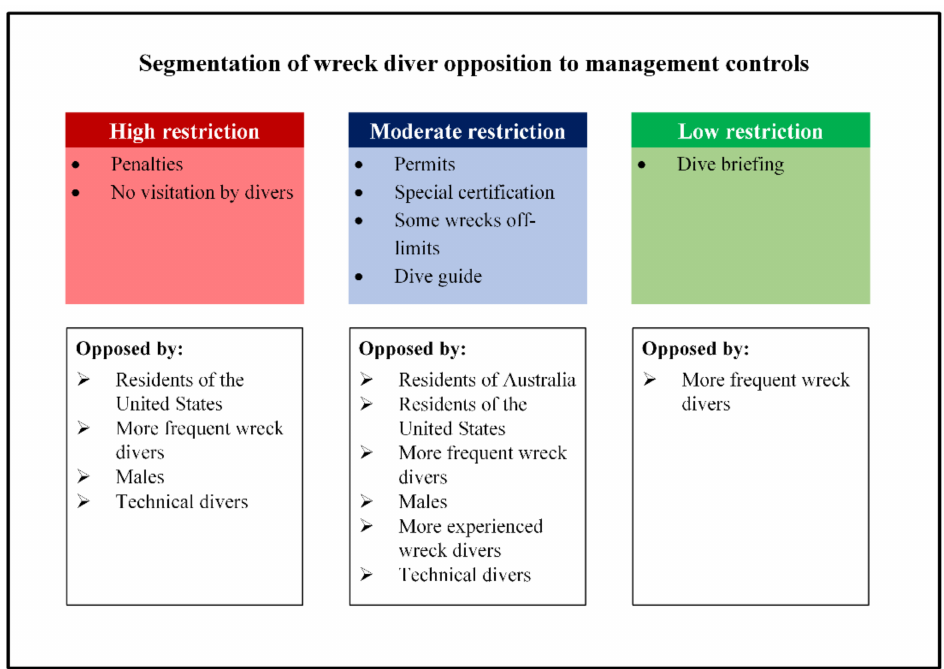
Figure 9. Segmentation of wreck diver opposition to management controls–adapted from [37] (p.